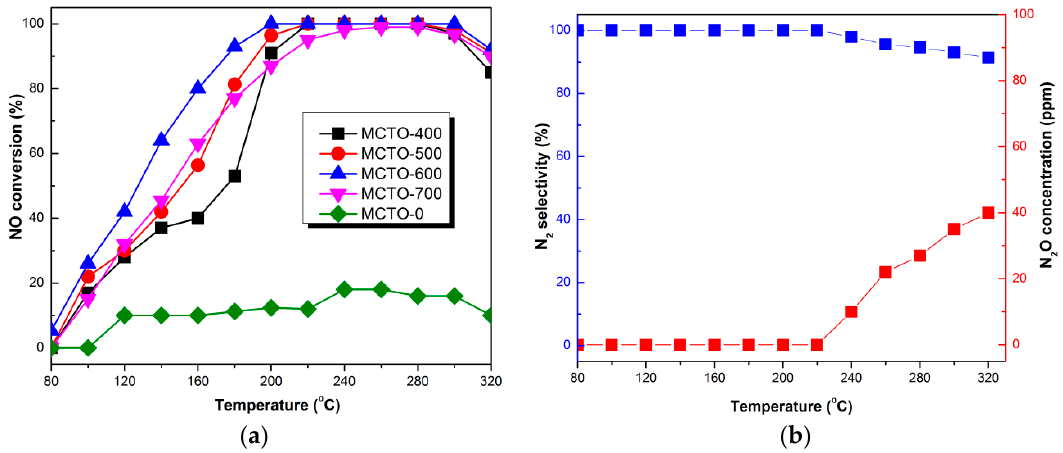
Figure 9. NH 3 –selective catalytic reduction (SCR) activity of MCTO-0, MCTO-400, MCTO-500, MCTO-600, and MCTO-700 catalysts ( a ). N 2 selectivity of MCTO-600 ( b ). Reaction conditions: 500 ppm of NO, 500 ppm of NH 3 , 5 vol. % of O 2 , balance N 2 , gas hourly space velocity (GHSV) = 14,400 h − 1 .